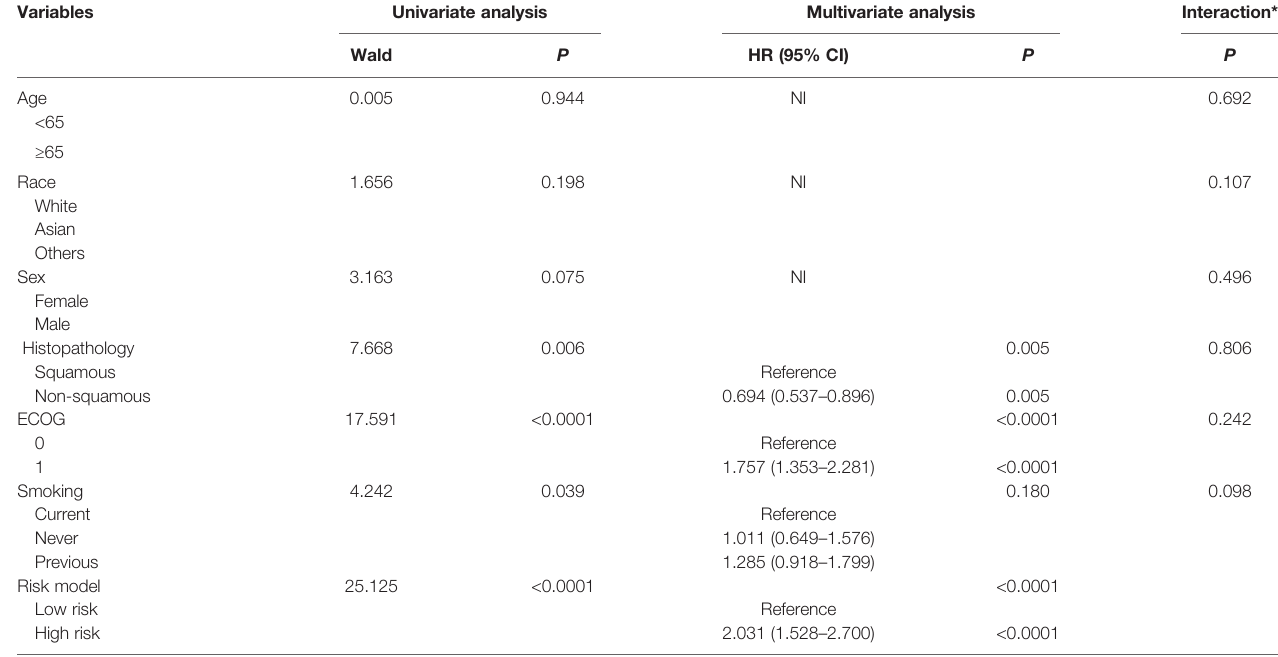
TABLE 1 | Univariate and multivariate Cox regression analysis of clinical variables affecting OS for patients receiving atezolizumab based on training and testing group.